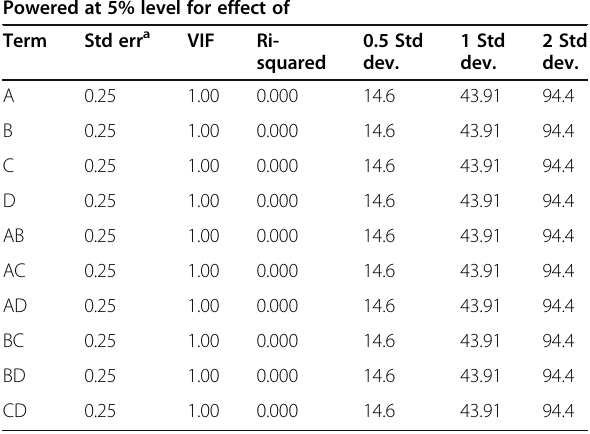
Table 5 Result of computed standard